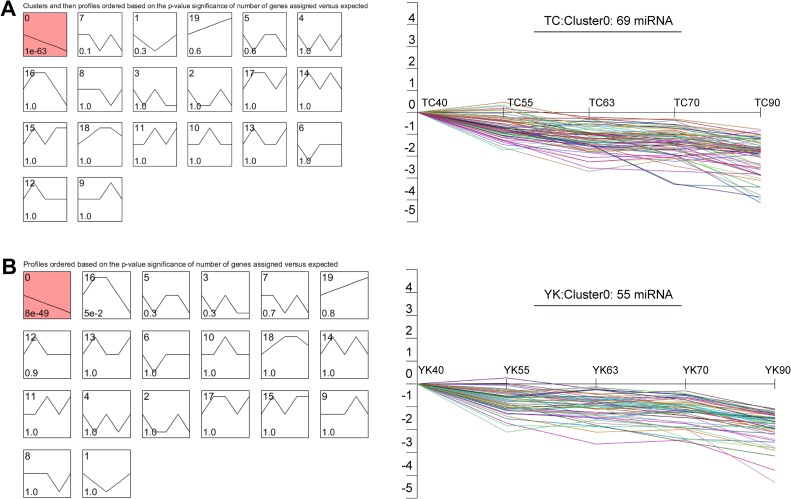
STEM clustering based on differentially expressed miRNAs.Each box corresponds to a kind of expression profile and only colored profiles reach statistical significance. The upper-left number in the box gives information about the order of profile. The bottom-left number gives information about the statistical significance. The right panel displays the patterns of miRNA expression for the “Cluster 0” profile in detail. A: Short time-series expression profiles of miRNAs in TC; B: Short time-series expression profiles of miRNAs in YK. TC: Tongcheng, YK: Yorkshire.